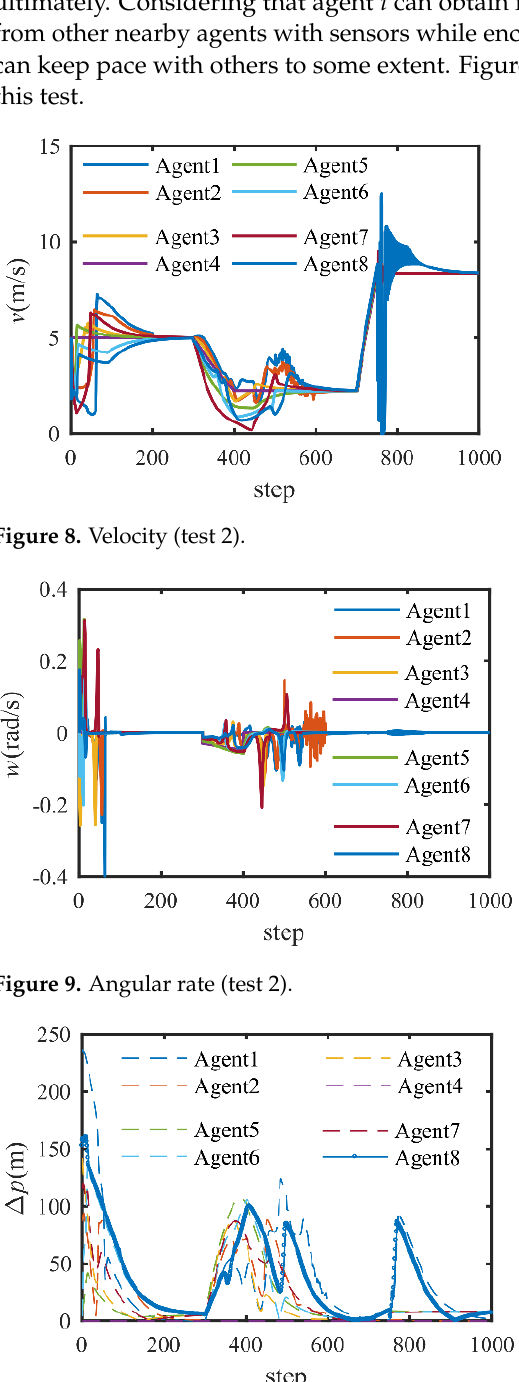
Figure 11. Track with communication breaks (test 2).